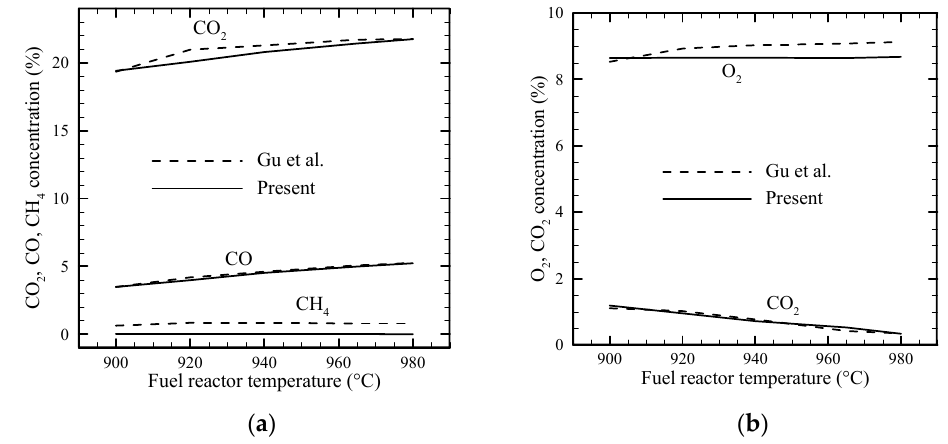
Figure 3. Variations in the ( a ) concentrations of CO 2 , CO and CH 4 in the fuel reactor and ( b ) in the concentrations of O 2 and CO 2 in the air reactor at the temperature of the fuel reactor.